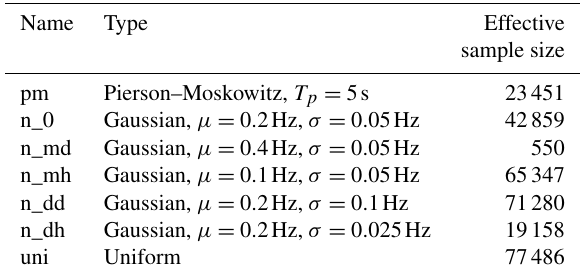
Table B1. Details of several weighting